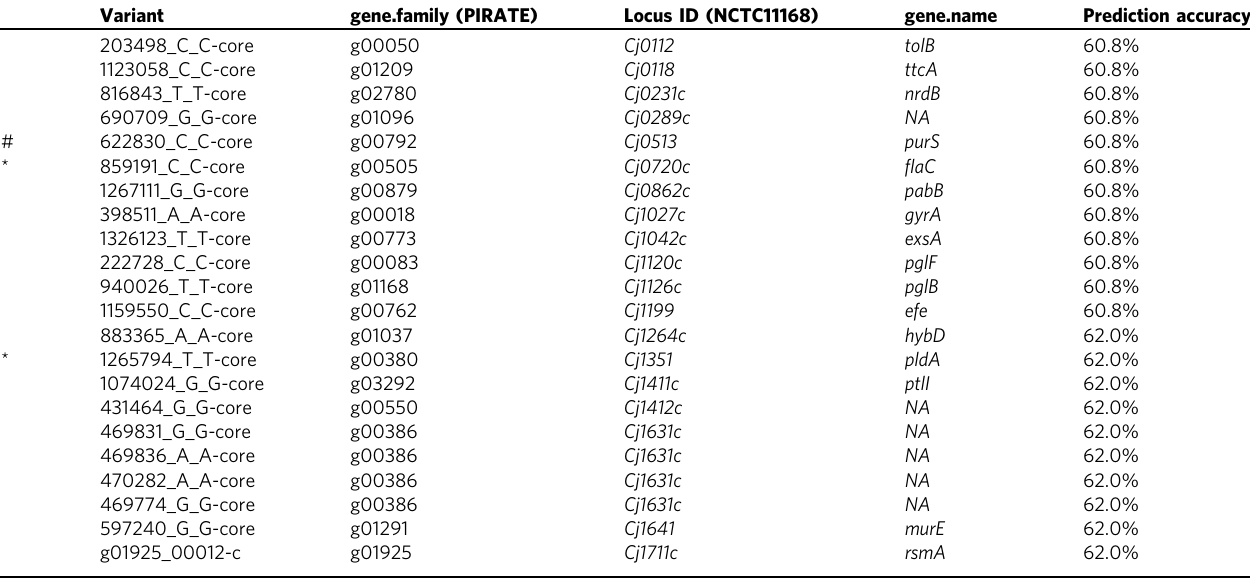
Table 3 Details of GWAS-informed markers ( n = 22) used to predict risk of subsequent PI-IBS. Variant